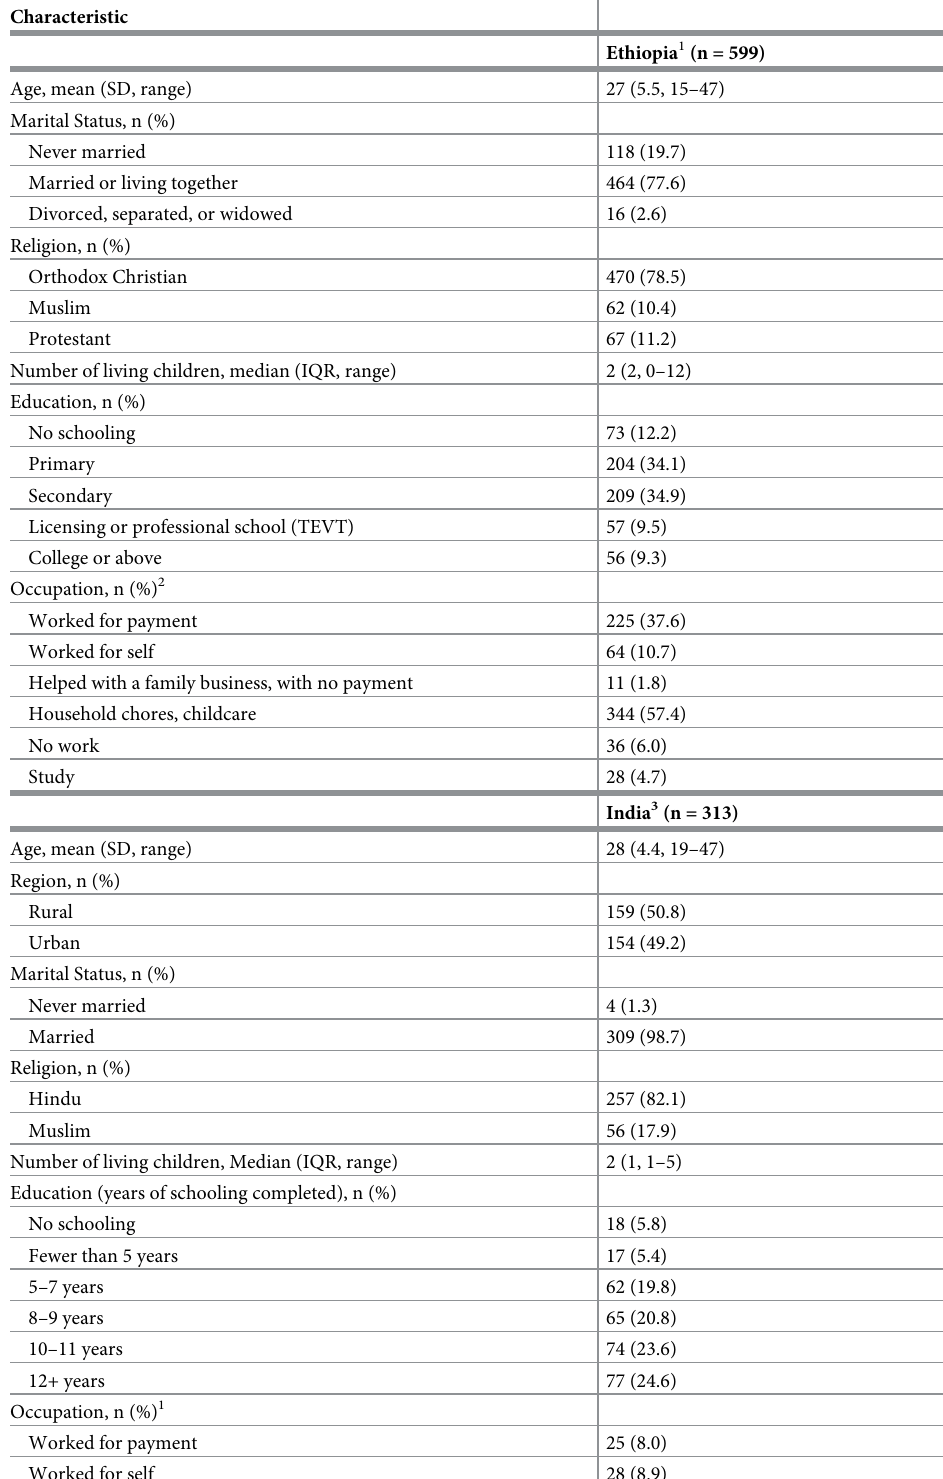
Table 1. Participant demographic